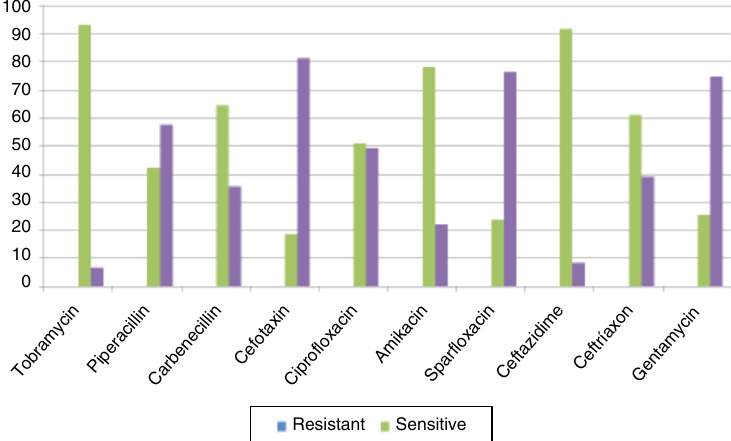
Sensitive Figure 2 Antibiogram of P. aeruginosa . in Fig. 1. Among P. aeruginosa , tobramycin 30 (cid:2) g/disk had the highest susceptibility rate as 93.2%, followed by ceftazidime 30 (cid:2) g/disk 91.5% and amikacin 10 (cid:2) g/disk 64.4%, given in Fig. 2. And 95.2% S. aureus isolates were